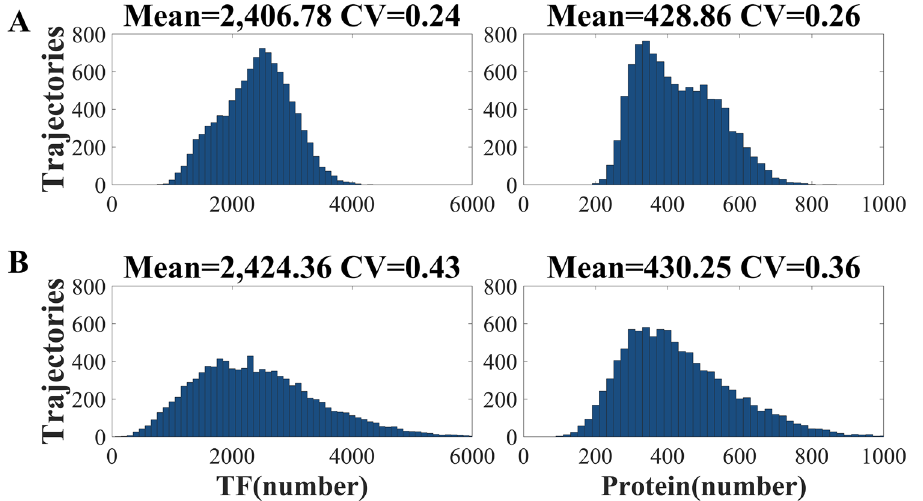
Figure 2. The noise propagation in the AM system. The x-axis is the expression level of TF A (left panels) or downstream protein (right panels). The y-axis is the number of trajectories (cells) having the TF A or protein level indicated by the x-axis. ( A ) Sharp distribution of TF A leads to low noise intensity at the protein level. ( B ) High CV of TF A results in broad distribution at the protein